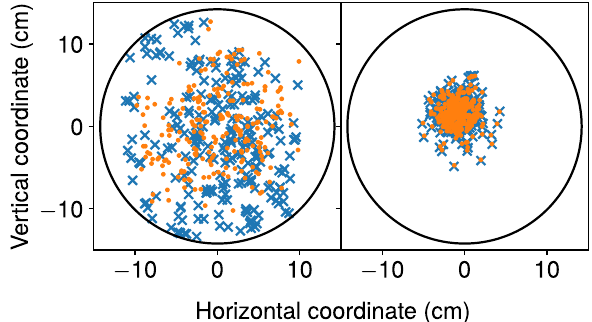
FIG. 6. Map of breakdown damage sites on copper cavity walls after high-power conditioning in zero-tesla external magnetic field (left) and three-tesla field (right). Damage locations are shown from the perspective of the “ downstream ” cavity wall in the foreground of Fig. 4; blue x ’ s denote damage on the upstream wall and orange dots denote damage on the downstream wall. Breakdown damage in a three-tesla magnetic field exhibits a one- to-one correspondence between opposite cavity